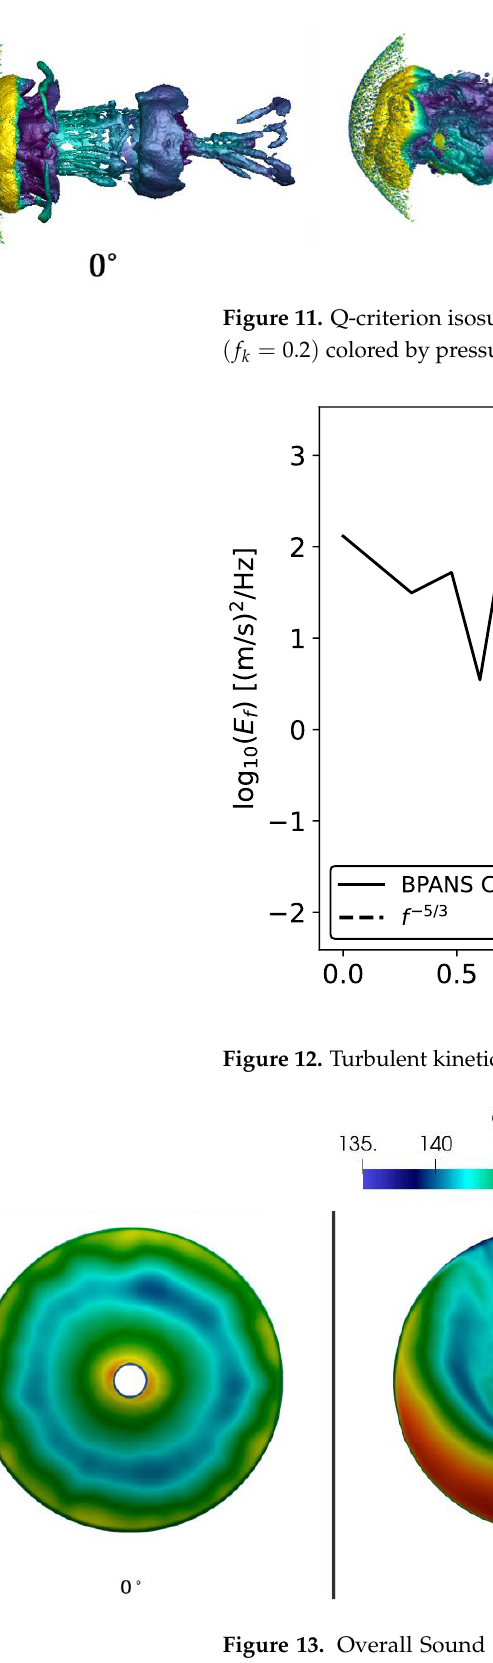
Figure 13. Overall Sound Pressure Level (OASPL) in decibels on the nose of the vehicle for the three angles of attack for BPANS CC ( 𝑓 𝑘 = 0.2) .